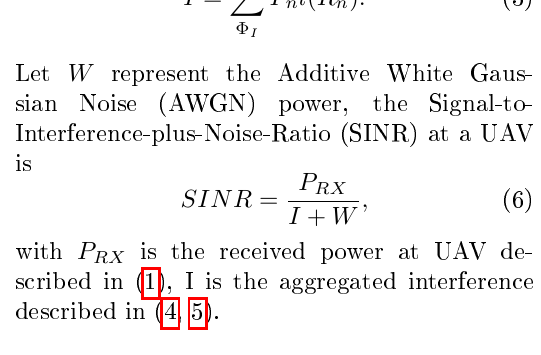
is done for suburban environment in